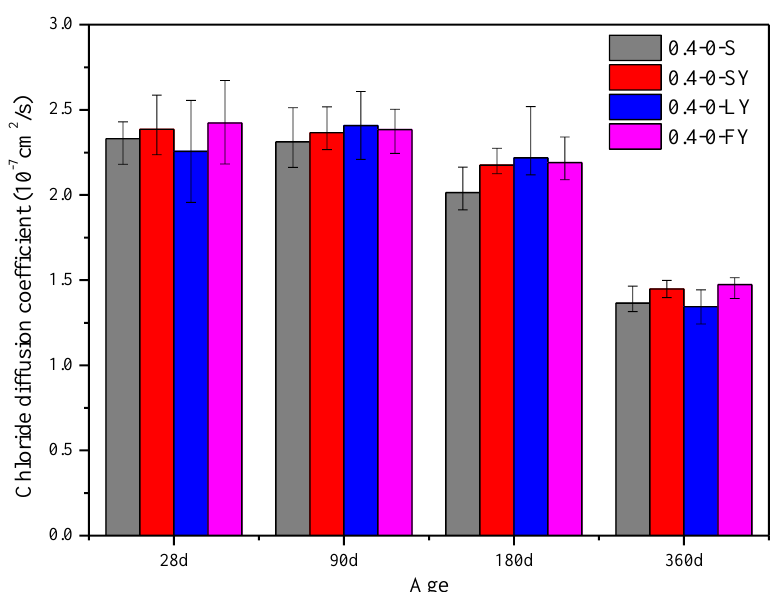
Figure 4. Chloride diffusion coefficient of C30 concrete. Materials 2022 , 15 , x FOR PEER REVIEW